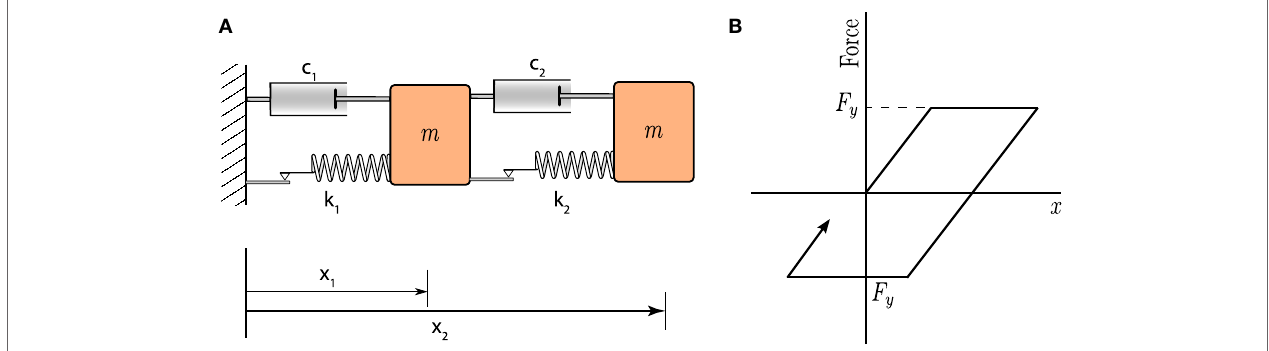
FIGURE 10 | System studied. (A) System of two masses connected with elastoplastic springs and linear dampers. (B) Behavior of elastoplastic spring.